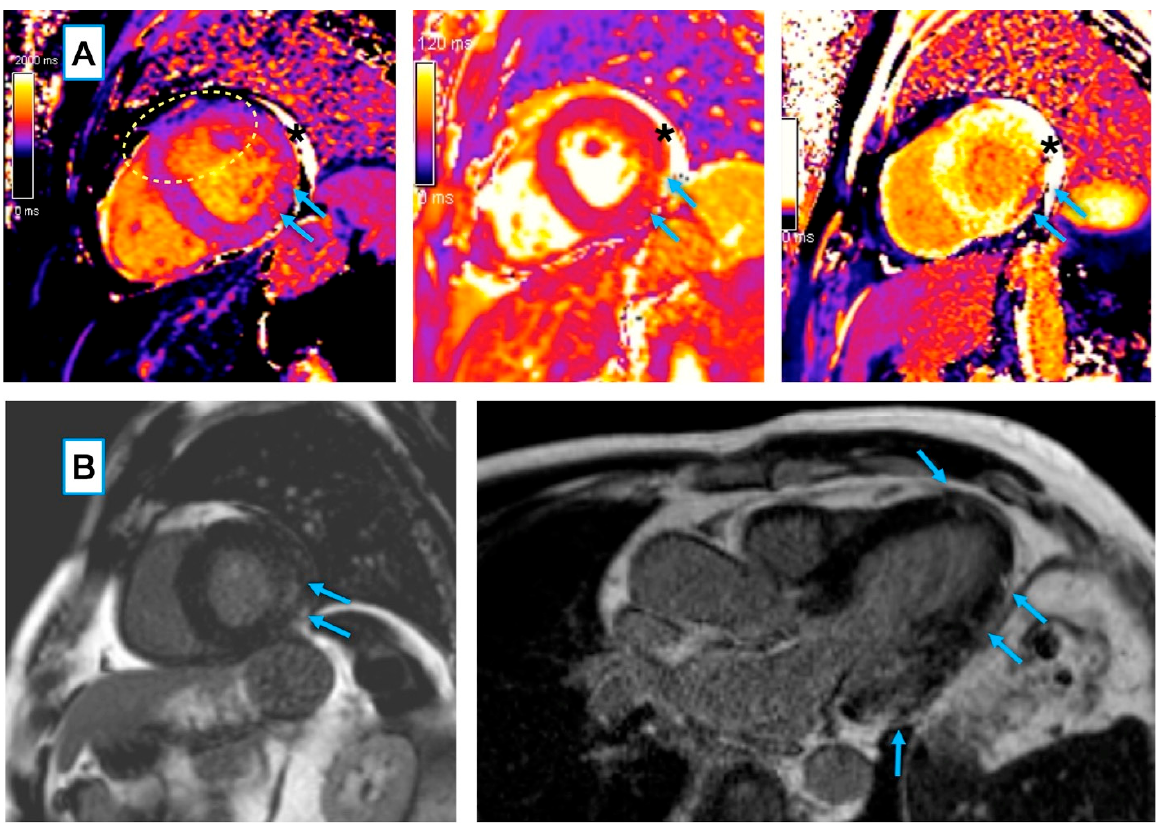
Figure 2. CMR features of myocarditis in a 68-year-old male patient 40 days post COVID-19 pneu- monia: ( A ) Locally increased native T1 ( left ) and T2 ( middle ) relaxation times in a mid-ventricular short axis slice, matched by markedly shortened post-contrast T1 ( right ), showing an area of acute in- jury/ongoing inflammation (arrows). Global T2 relaxation time was normal at 48 ms (the institutional reference range: 39–49 ms), with local elevation in the basal inferolateral segment (arrows; segmental ROI average T2 = 57 ms). Global T1 value was slightly elevated at 1083 ms (the institutional reference range: 951–1035 ms), with a more pronounced increase in the basal inferolateral segment (arrows; segmental ROI average T1 = 1121 ms). The dashed oval marks an area of the artifact related to suboptimal motion correction that was not included in the measurement. * An asterisk marks small pericardial effusion. ( B , left ) A corresponding intramyocardial area of LGE, suggestive of at least some extent of inflammatory necrosis/fibrosis (arrows) within the zone of acute injury. ( B , right ) In a three-chamber long axis slice, the LGE pattern also includes subtle subepicardial spots along the inferolateral wall, as well as in the apical septal segment (arrows). CMR, cardiac magnetic resonance; LGE, late gadolinium